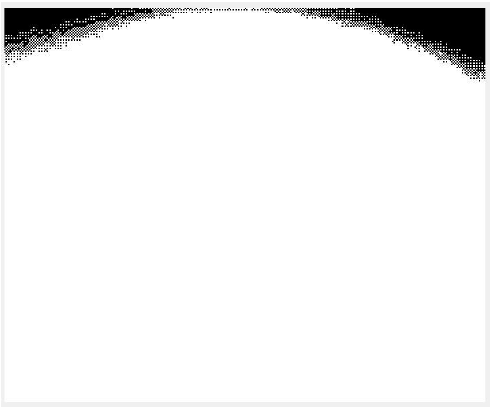
Figure 8. An example of fingertip image intensity-based detection results obtained from a smartphone video camera.